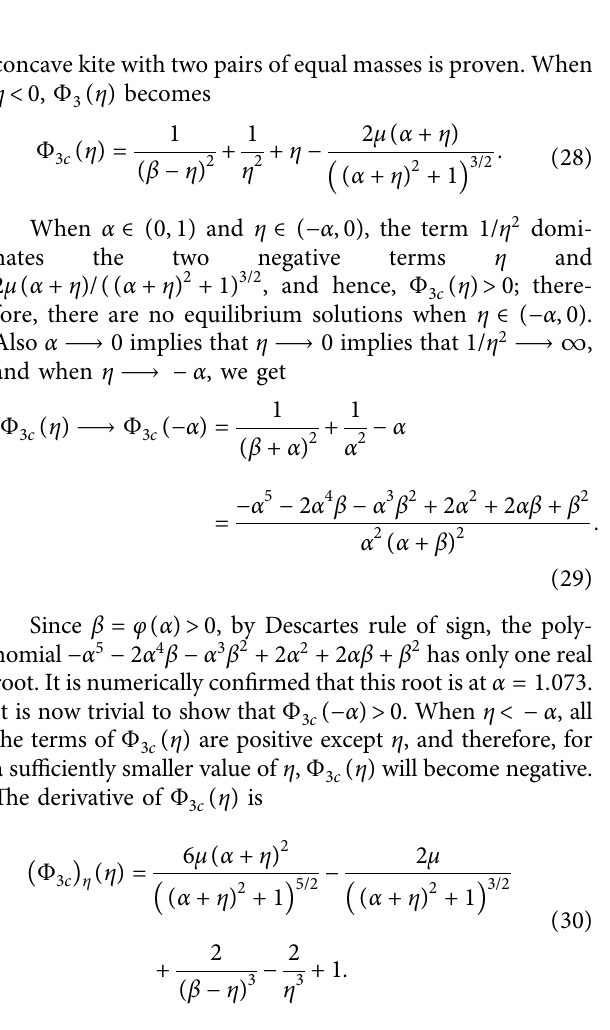
� m � m and m . Te curve shaded black corresponds to the equilibrium 1 3 2 4 ( ζ ) � 0 and Φ ( ζ ) � 0, and the curve shaded black corresponds to the solutions of Φ 4 a 4 b